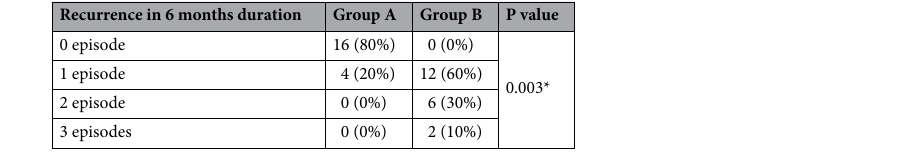
Table 5. Comparison of number of recurrent episodes during 6 months follow up in group A and group B. * highly